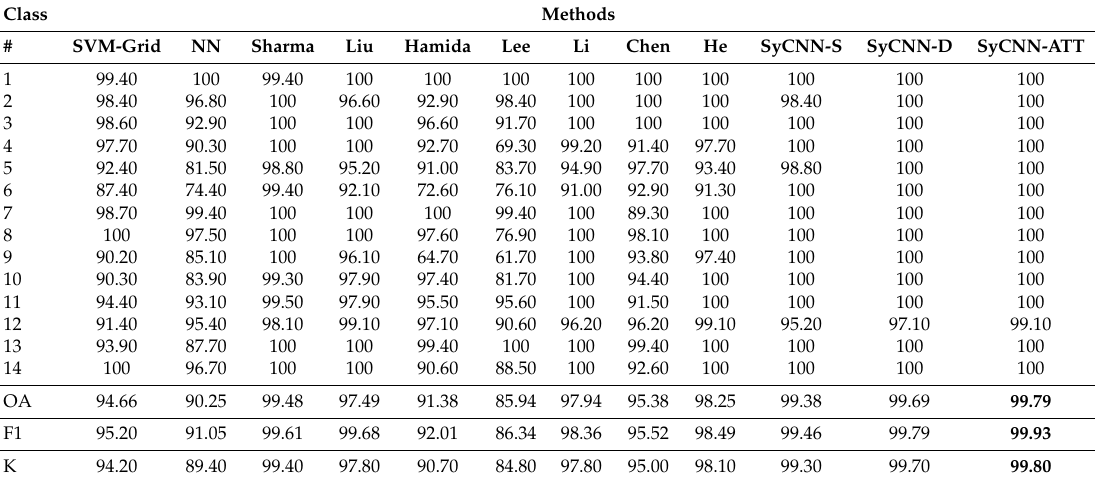
Table 5. Comparative evaluation based on the Botswana Scene